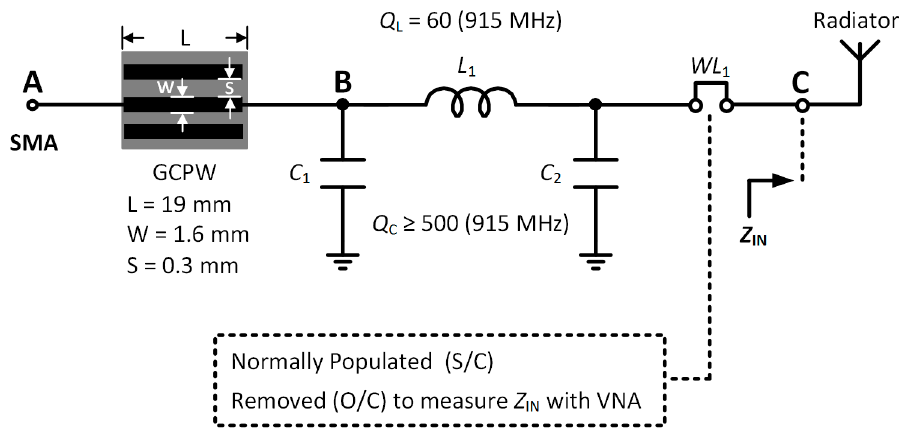
Figure 9. π -type matching network implemented in the sensor device.